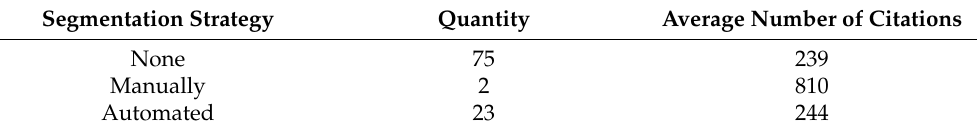
Table 11. Segmentation